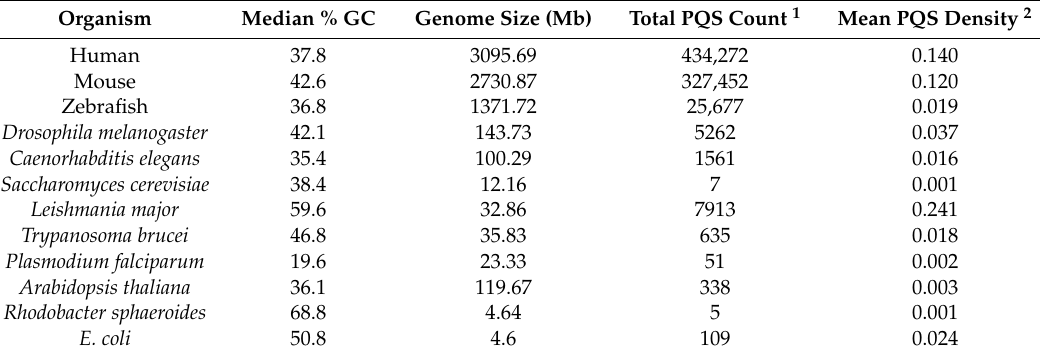
Table 2. Genome metrics and quadruplex sequences in various